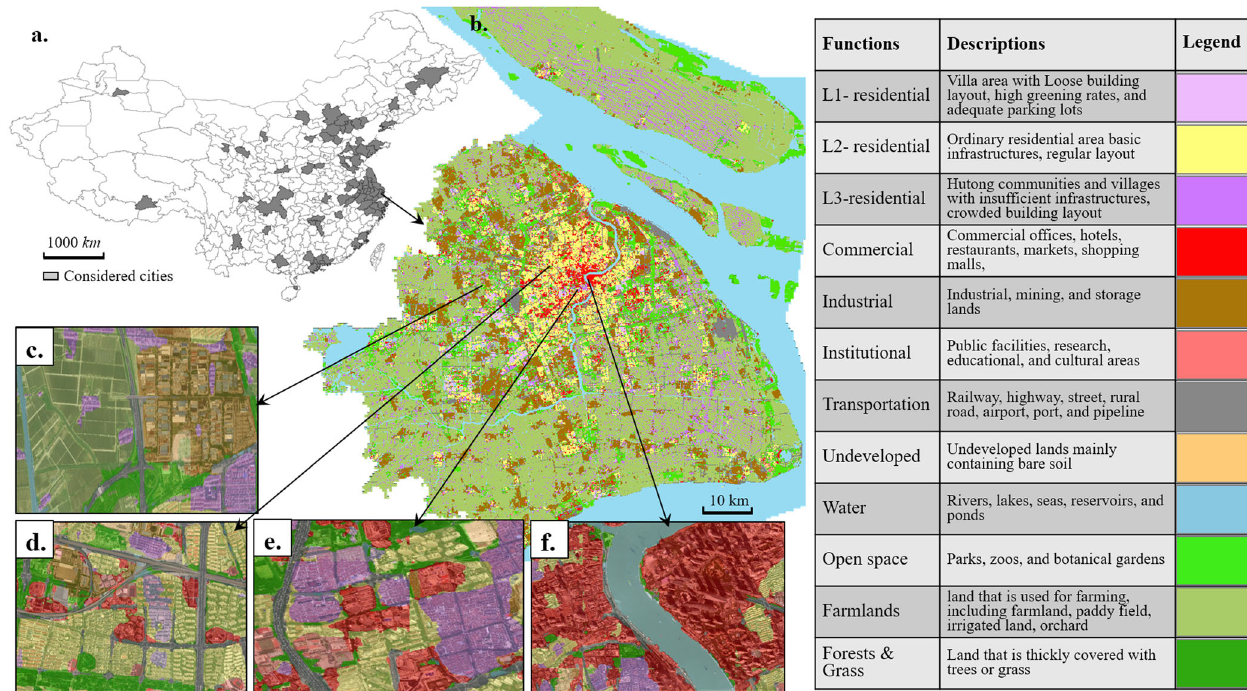
Fig. 1 Land functional zone maps of 81 major cities across China. a Distributions of the considered 81 cities whose names and detailed information are provided in the Supplementary Fig. 6. b Land functional zone map exempli fi ed for Shanghai. The legend illustrates the 12 functional classes derived. c – f , Four selected regions in Shanghai to illustrate the land functional zones in details, where the maps are set at 60% transparency and overlapped with satellite